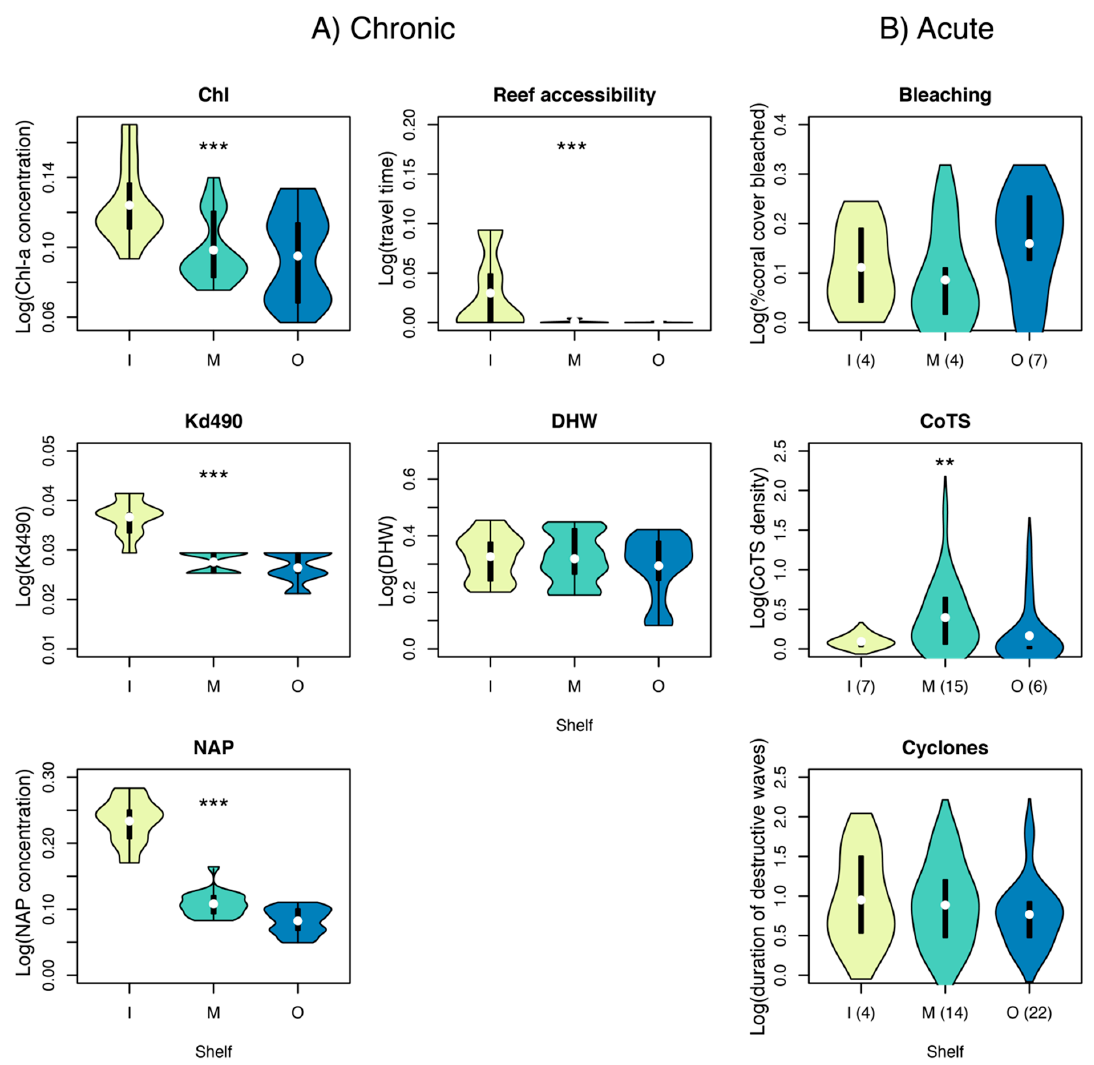
Figure 5. Distribution of chronic ( A ) and acute ( B ) stressors among inner ( I ), mid ( M ) and outer ( O ) shelf reefs. Violin plots represent data density, with plot width being proportional to the amount of data. Thick vertical lines represent the interquartile range, and the white dot the median. Asterisks show significant cross-shelf variation based on a Kruskal–Wallis test (***: P < 0.001; **: P < 0.01). For acute stressors, numbers in brackets represent the number of discrete disturbances. With Chl: long-term average of chlorophyll-a concentration; Kd490: light attenuation coefficient; NAP: non-algal particulates; DHW: Degree Heating Weeks; CoTS: outbreaks of the Crown-of-Thorns sea star ( Acanthaster cf. solaris ).